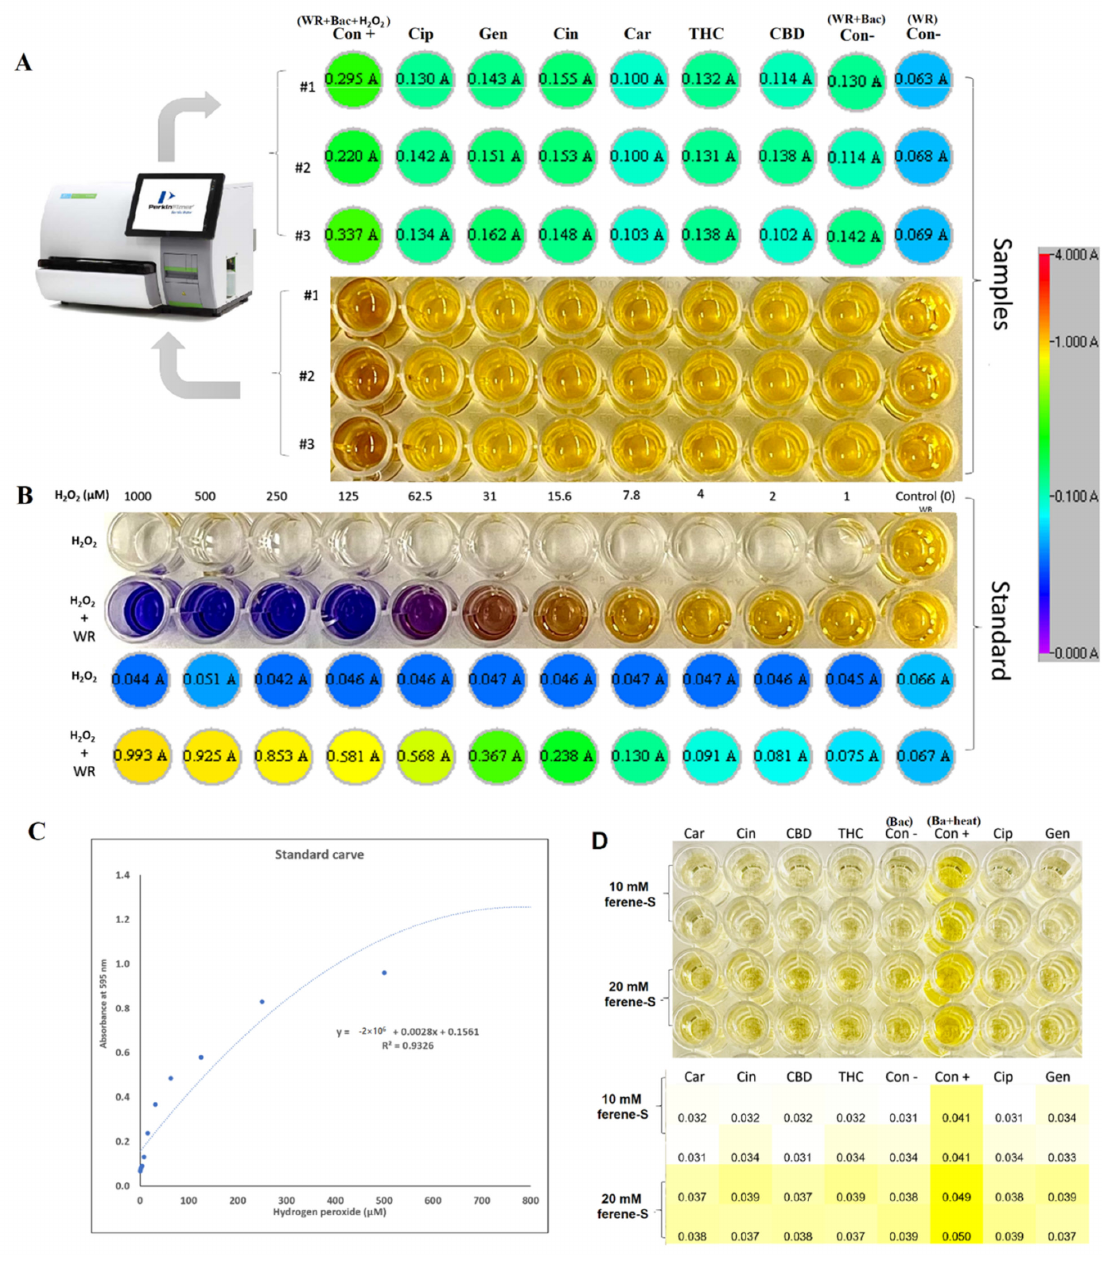
Figure 2. Hydrogen peroxide and free iron [(ferrous) Fe 2+ ] concentration. ( A ) H 2 O 2 concentrations in the samples with the naked eye (down) and plate reader (upper), with ciprofloxacin and gentamycin used as the internal controls. ( B ) Standard 1 mM solution of hydrogen peroxide serially diluted with double-distilled (DD) water 1:2 for a total of 11 samples. DD water was used as the blank working reagent (WR) as a negative control, and bacteria treated with 250 µ M H 2 O 2 as a positive control. ( C ) Standard curve after calculating standard curve based on standard concentrations and OD means; H 2 O 2 concentrations of all samples were calculated based on R 2 value. ( D ) Free iron [(ferrous) Fe 2+ ] concentration in a P. aeruginosa lysate after 1 h treatment with selected PBCs. Bacterial incubated in 95 ◦ C for 10 min to break the Fe-S complex as a positive control. The naked eye (upper) heatmap (down) is illustrated in the panels. Con+: control-positive (Bacteria + WR + H 2 O 2 ); Con − : control- negative (Bacteria + WR); Cin: cinnamaldehyde; THC: tetrahydrocannabinol; CBD: cannabidiol; Cip: ciprofloxacin; Gen: